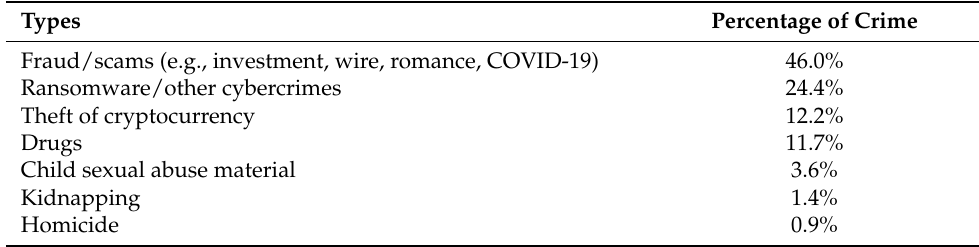
Table 1. Relative frequency of crimes associated with